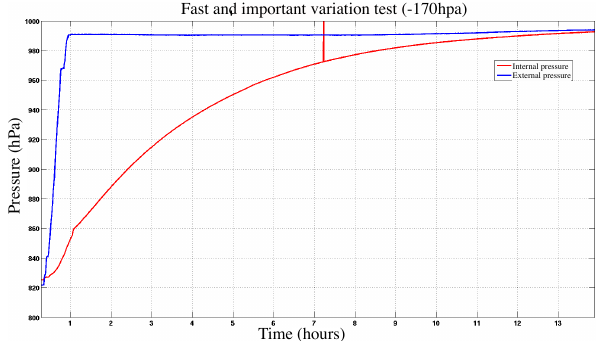
Fig. 3. schematic of our new installations